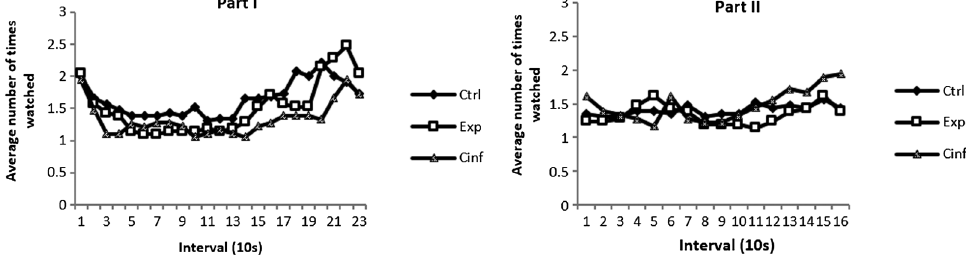
FIG. 14. Average number of times students watched every 10 s segment of the animated